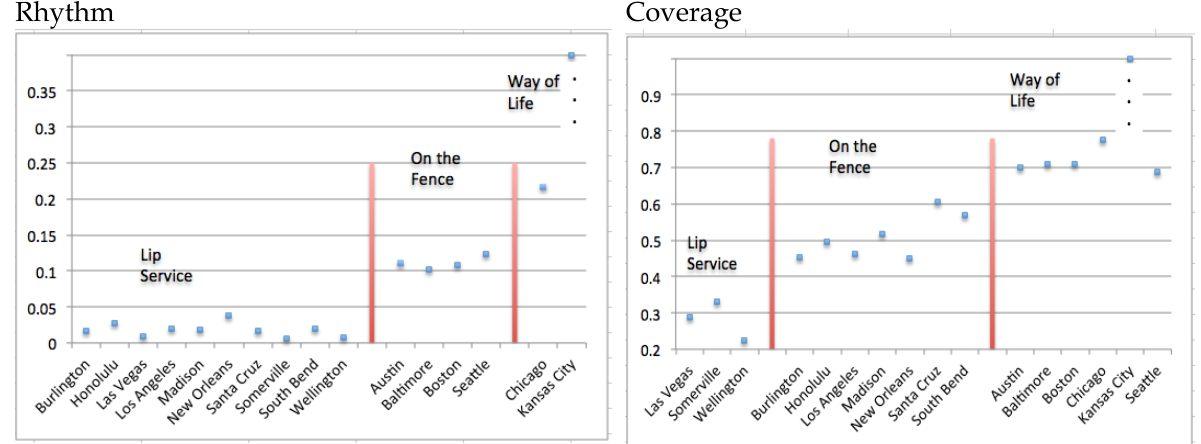
Figure 2: Testing the Four Indicators of the OGD Heartbeat Rhythm Coverage